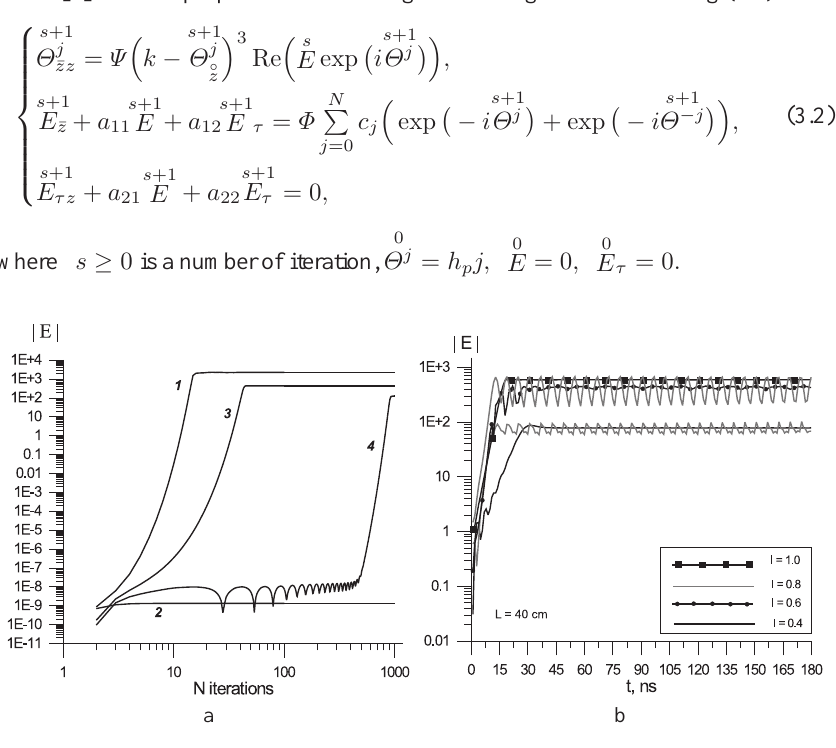
Figure 2. Numerical solutions: (a) stationary system, dependence on the number of iterations, (b) nonstationary system, dependence on t